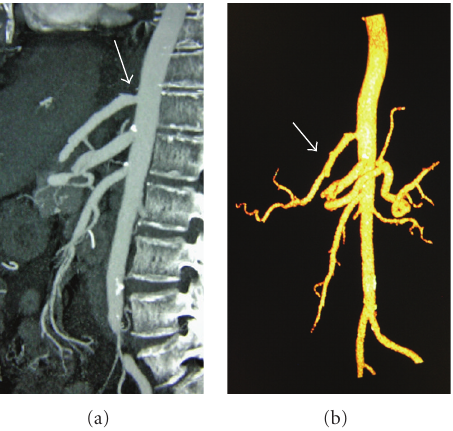
Figure 2: (a) Thin section two-dimensional sagittal CTA recon- struction of the aorta shows the anastomosis (arrow) of the hepatic artery to the proximal abdominal aorta superior to the celiac trunk and superior mesenteric artery (SMA). (b) Colorized three- dimensional volume rendered obliquely oriented CTA reconstruc- tion shows the course of the donor hepatic artery (arrow) from the aorta to the proper hepatic artery